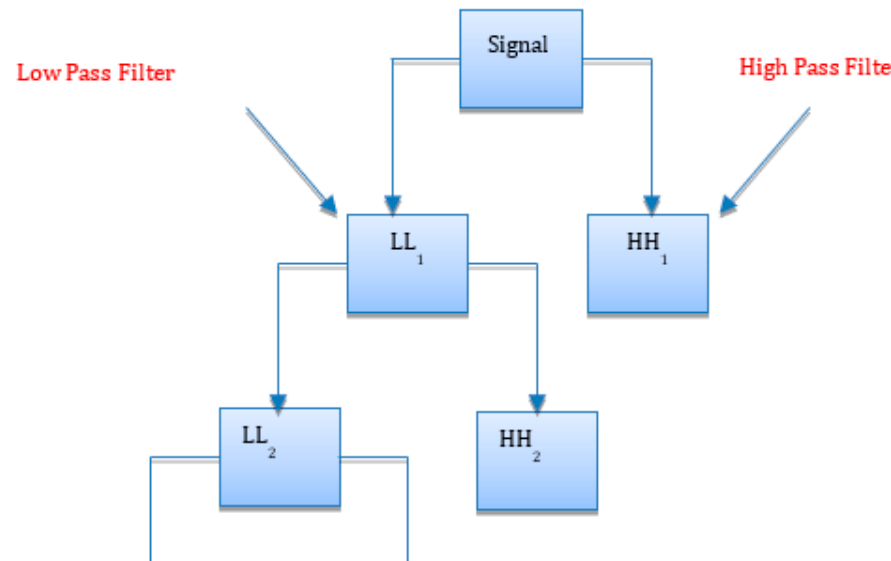
Figure 4. Signal Analysis.